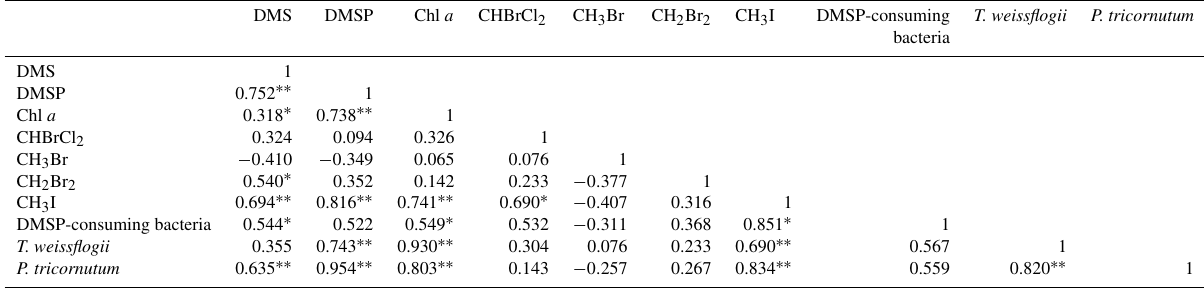
Table 3. Correlation between dimethylsulfide (DMS), dimethylsulfoniopropionate (DMSP), chlorophyll a (Chl a) , bromodichloromethane (CHBrCl 2 ), methyl bromide (CH 3 Br), dibromomethane (CH 2 Br 2 ), iodomethane (CH 3 I), DMSP-consuming bacteria, Thalassiosira weiss- flogii ( T. weissflogii ) and Phaeodactylum tricornutum ( P. tricornutum ) concentrations in the high p CO 2